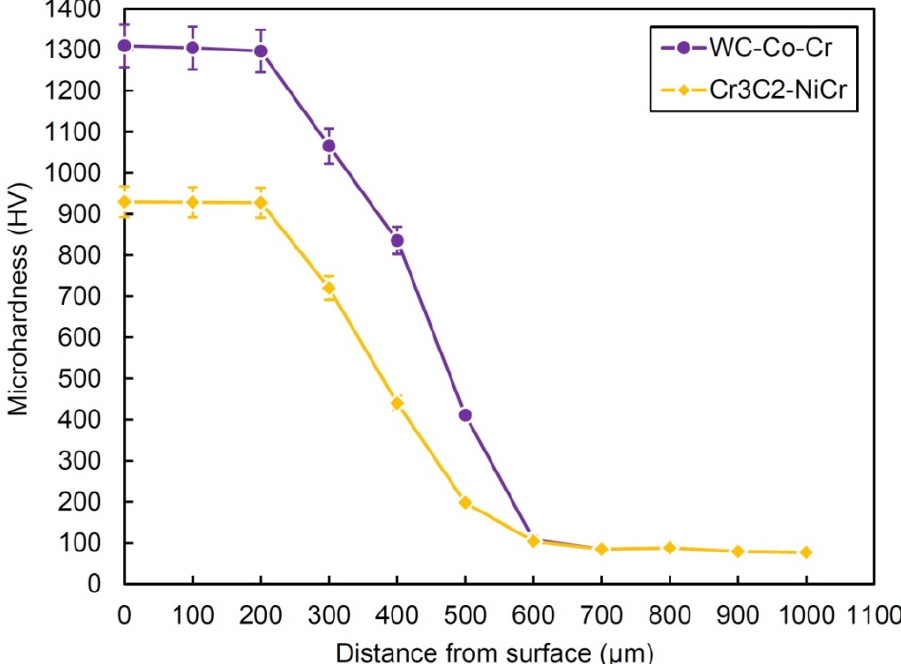
Figure 5. Microhardness vs. distance from surface profiles of A356 with Cr 3 C 2 -NiCr and WC-Co-Cr HVOF-sprayed coatings.